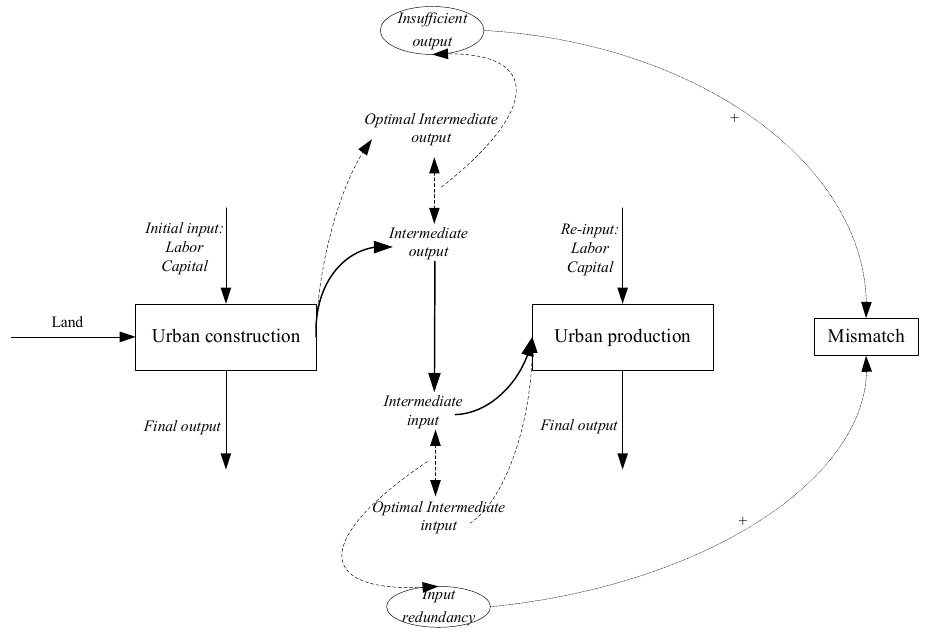
Figure 1. Framework of mismatch between urban construction and urban production.